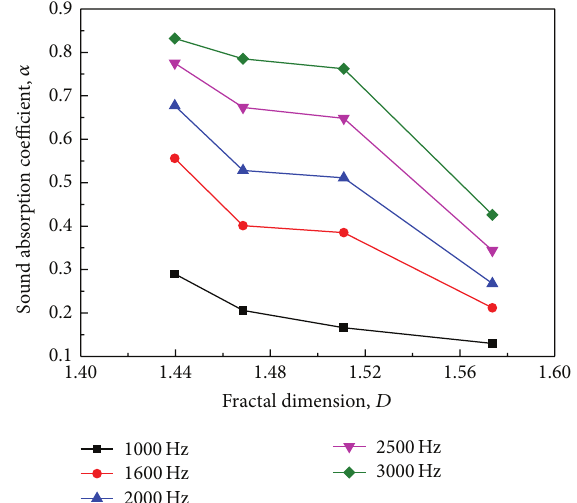
Figure 6: Sound absorption coefficient versus fractal dimension for porous metal fiber materials.